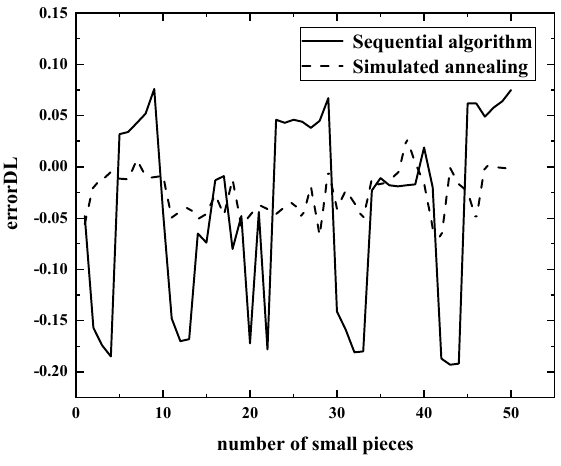
Figure 12. Comparison of errorDL. Table 3. Result statistics.